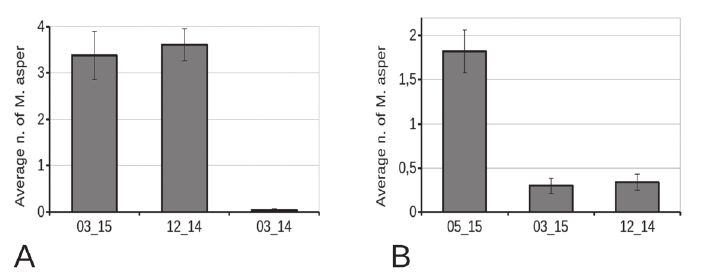
Figure 7. Average number of M. asper observed each week on single wood piles built with logs cut in different periods at Bosco della Fontana. A first experiment B second experiment (for details see text). Error bars represent standard errors.